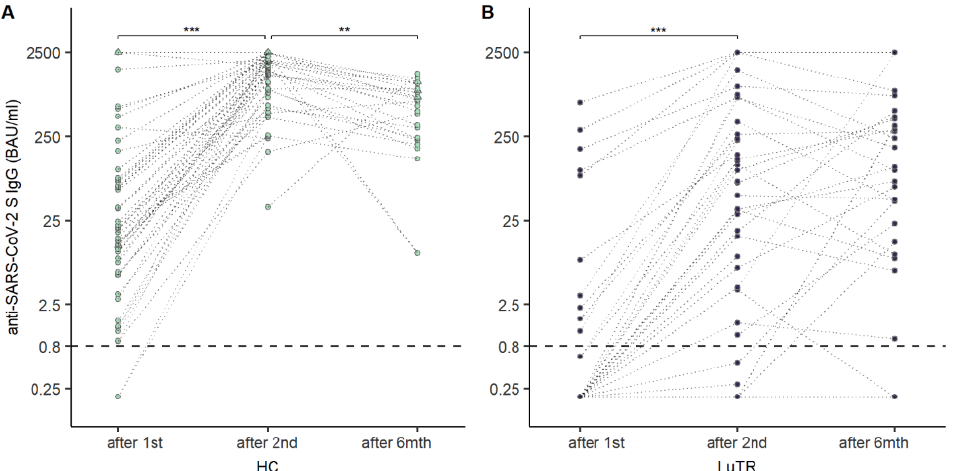
Figure 2. Change in SARS-CoV-2 S antibody levels (BAU/mL) over time in HCs ( A ) and LuTRs ( B ). Upper level of quantification: 2500 BAU/mL. The horizontal line indicates the cutoff for seroconversion. Circles represent individual antibody levels. Participants with a history of COVID-19, prior to immunization, are presented as triangles. Darker lines indicate overlapping points. (**, *** significant).